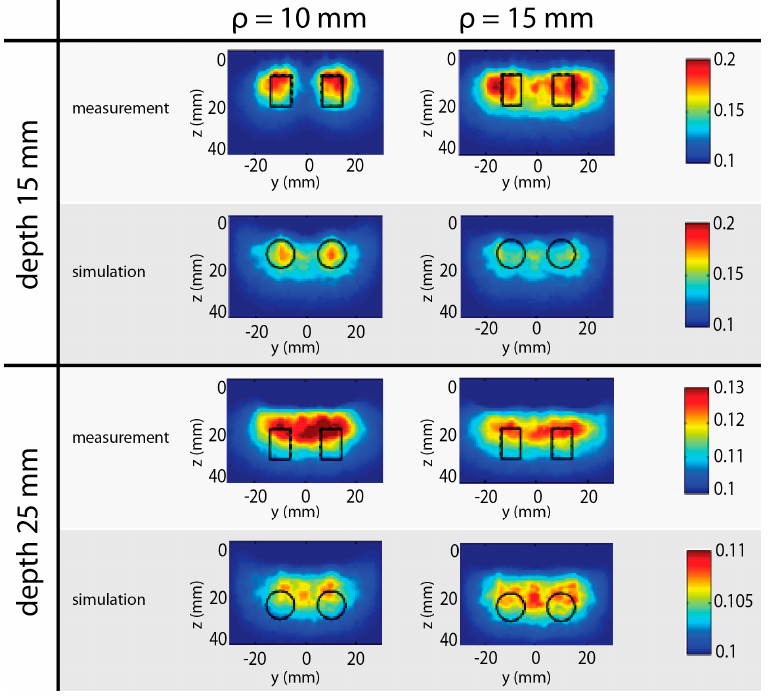
Figure 14. Reconstructions of inclusion I1 and I2 (set at the same depth, 15 or 25 mm), obtained for 10 and 15 mm ρ . Results obtained in the same conditions (inclusion depth and ρ ) are computed both on simulated and experimental curves [144]. In the simulation, spherical perturbations were used while in the measurements cylindrical (almost rectangular) ones were adopted. However, it has been demonstrated for totally absorption inclusion that different shapes (e.g., cylinder or sphere as in this case) yield to comparable optical perturbation provided that the volume is the same [145].